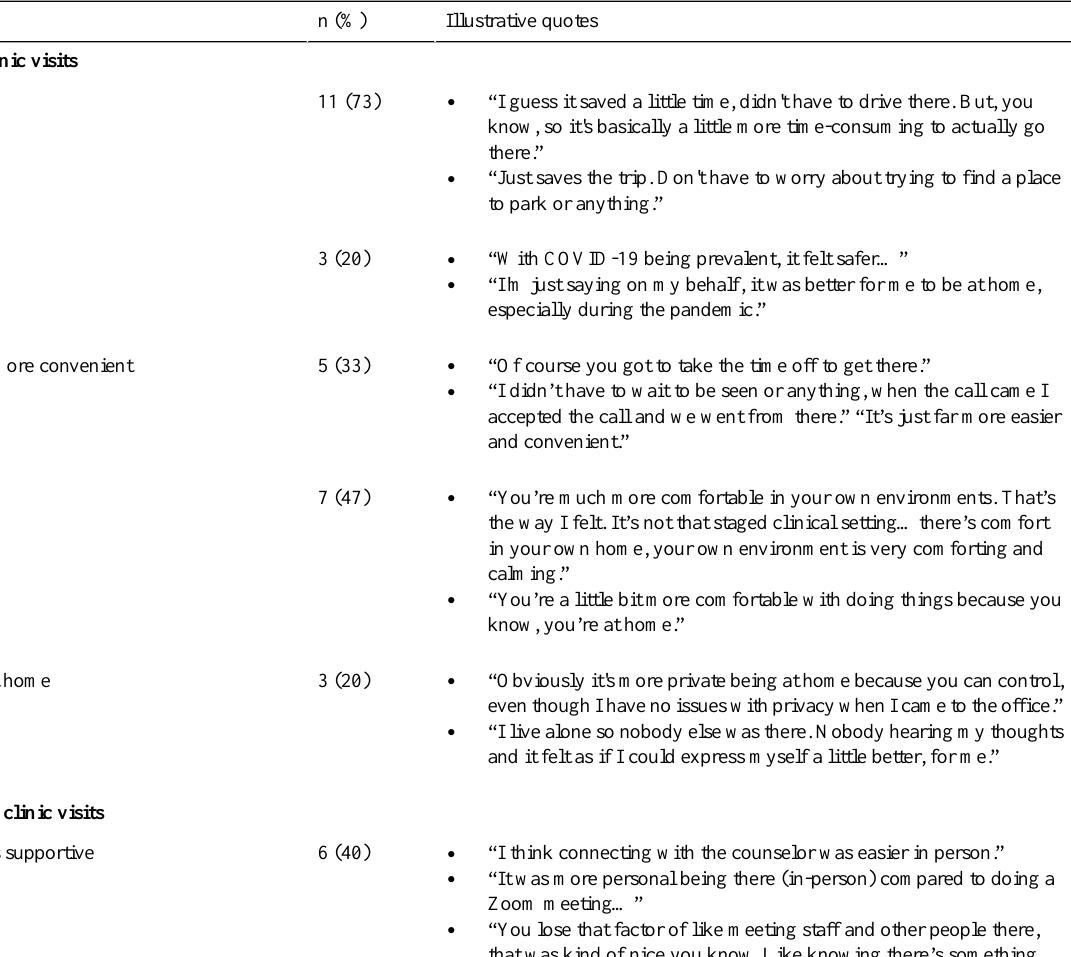
Table 6. Dominant themes and subthemes based on structured interviews with smoking cessation clinical trial participants (n=15) who completed both in-person and remote clinic